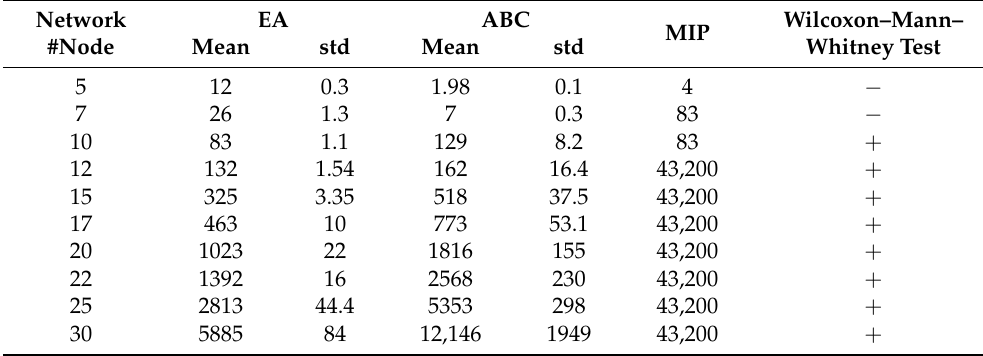
Table 2. Comparison of the computation time (sec.) for the BLP model together with the outcomes of the paired Wilcoxon test. Symbols + , − and = indicate whether the EA algorithm was better ( + ), worse ( − ) or equal ( = ) to the ABC algorithm.